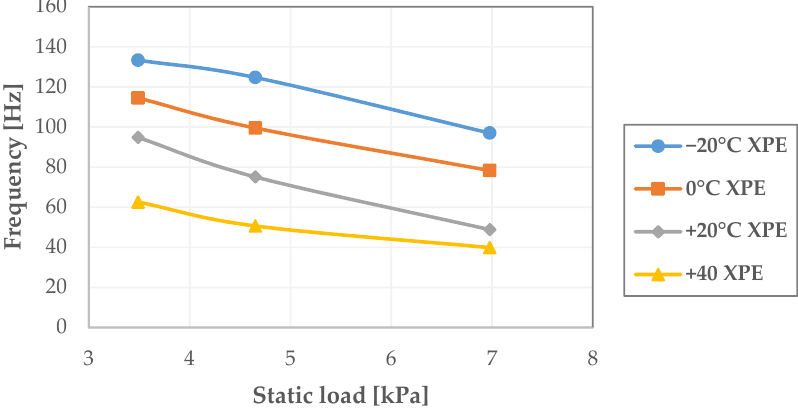
Figure 10. Resonant frequencies of XPE as a function of temperature.